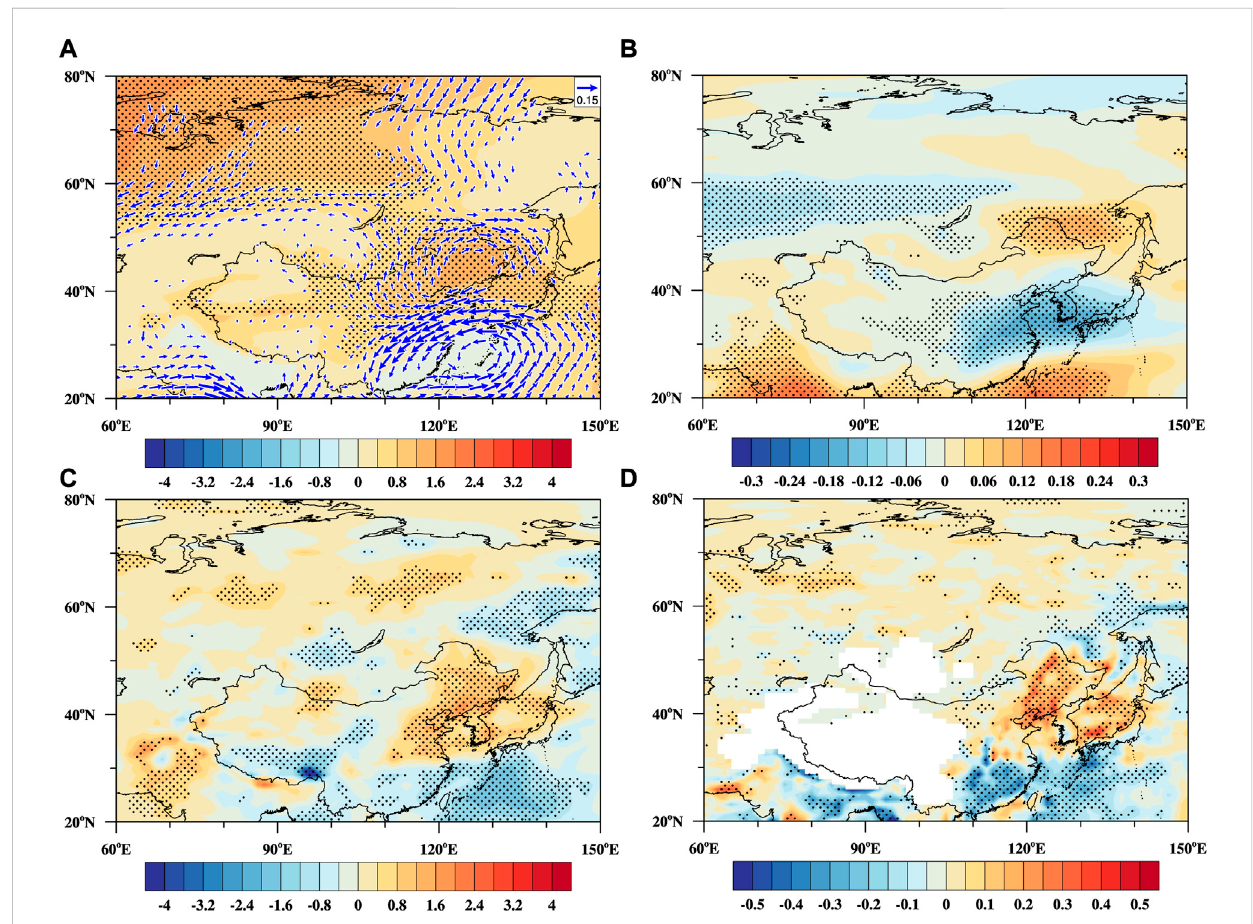
FIGURE 8 Regressions of summer anomalous (A) 850 hPa geopotential height (shading; unit: m) and horizontal wind (vector; unit: m s – 1 ), (B) 850 hPa zonal wind (unit: m s – 1 ), (C) 500 hPa vertical velocity (unit: 10 – 3 Pa s – 1 ), and (D) moisture divergence vertically integrated from the surface to 850 hPa (unit: 10 – 5 kgm – 2 s – 1 ),againstthenormalizedCDDAindexintheCESM-LEMMEduring2071 – 2100.Stippledregionsandvectorsindicatethattheanomaliesare signi fi cant at the 95% con fi dence